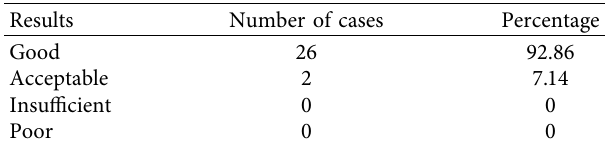
Table 3: Clinical evaluation according to the Biga SOFCOTcriteria [23].